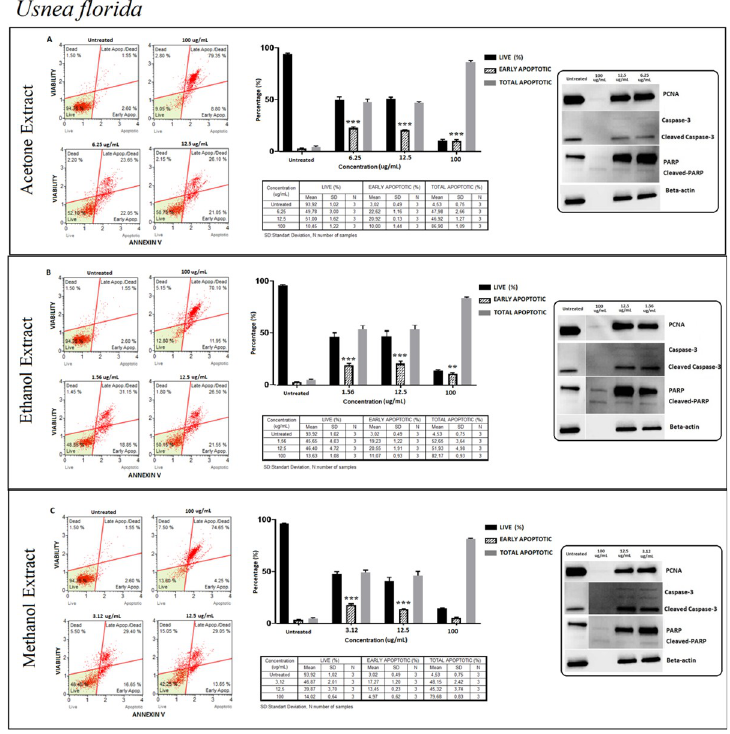
Fig 10. Usnea florida (UF); Annexin V/7’AAD staining flow cytometry results (scatterplots), statistical analysis (bar graphs), ± SD changes between experiments (tables) and protein levels of PCNA, caspase-3 and PARP by western blot (right panel) on PC-3 cells with three different extraction of acetone (results compiled in A), ethanol (results compiled in B) and methanol (results compiled in C) respectively. Annexin V/7’AAD staining by flow cytometry of UF on PC-3 cells was shown to induce apoptotic cell death by mainly early apoptosis. The gating was adjusted according to the untreated sample and the representative scatterplots were presented as the percentage of cells that were viable (Ann-V − and 7-AAD − ), early apoptotic (Ann-V + and 7-AAD − ), late apoptotic (Ann-V + and 7-AAD − ), and dead (Ann-V − and 7-AAD + ). Scatterplots are shown for untreated, 100 μ g/mL, 12.5 μ g/mL and 6.25 μ g/mL after 48 hours treatment with acetone extract (A) and for ethanol extract treatment, groups are untreated, 100 μ g/mL, 12.5 μ g/mL and 1.56 μ g/mL after 48 hours treatment (B) and for methanol extract treatment, groups are untreated, 100 μ g/mL, 12.5 μ g/mL and 3.12 μ g/mL after 48 hours treatment (C) respectively. The 100 μ g/mL concentration is determined as toxic dose for all treatment groups. Results were analyzed and presented as the percentage of three independent experiments of live, early apoptotic and total apoptotic after treatment (bar graphs). Flow cytometry was shown to induce apoptotic cell death by mainly early apoptosis. The significance of only early apoptosis for each concentration indicated with an asterisk and the p value was only presented when the significance level of early apoptosis rate between 0.05 and 0.01. ± SD changes between apoptosis assays were indicated as the mean value and SD changes per concentration and per group of live-early apoptotic-total apoptotic separately (table). Western blot results of proliferating cell marker PCNA and apoptosis-related proteins (right panel) were presented. Dose-dependent PCNA, cleavage of caspase-3 and, PARP respectively. Apoptosis rate seems increased significantly by treatment with specified concentrations by flow cytometry however western blot data showed otherwise, particularly for cleaved-PARP. In addition, the proliferation (PCNA) status remained stable. � p < 0 . 05 , �� p < 0 . 001 , ��� p < 0 . 0001 (all p-values were obtained by two-way ANOVA following Dunnet’s multiple comparison